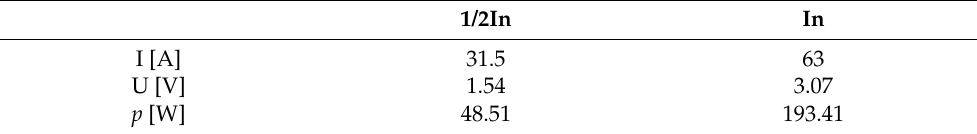
Table 4. Values obtained during measurement of the dissipated power in 63 A